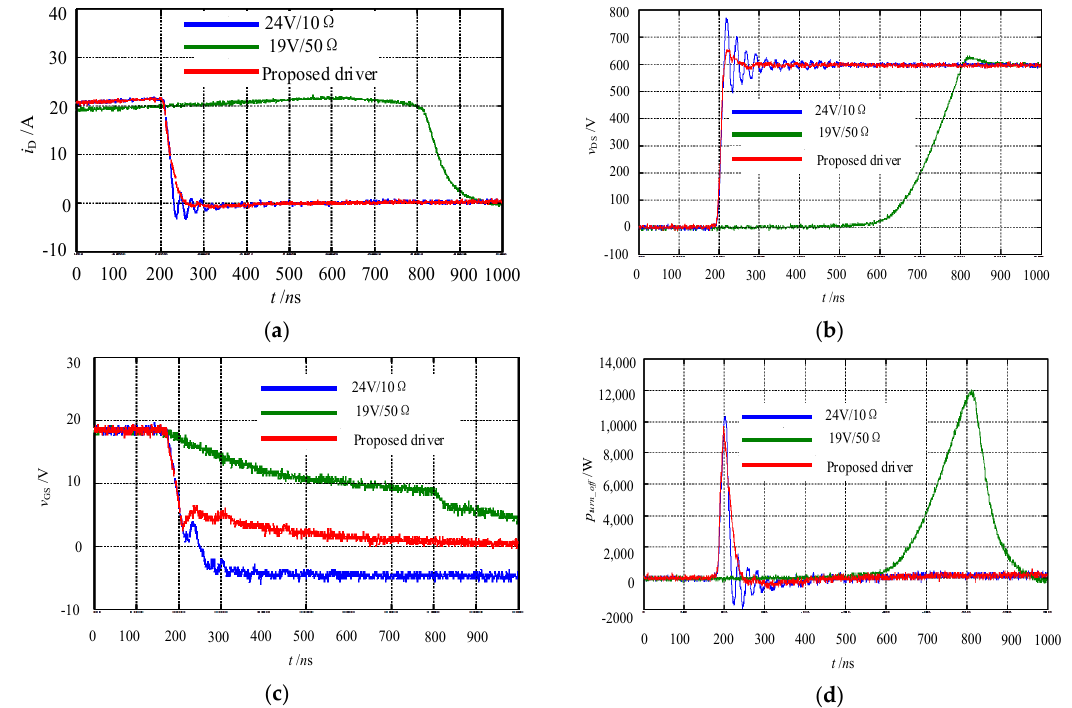
Figure 11. Switching waveforms based on different gate drivers: ( a ) Turn-off current waveforms, ( b ) Turn-off voltage waveforms, ( c ) Gate driving waveforms, and ( d ) Turn-off loss waveforms.